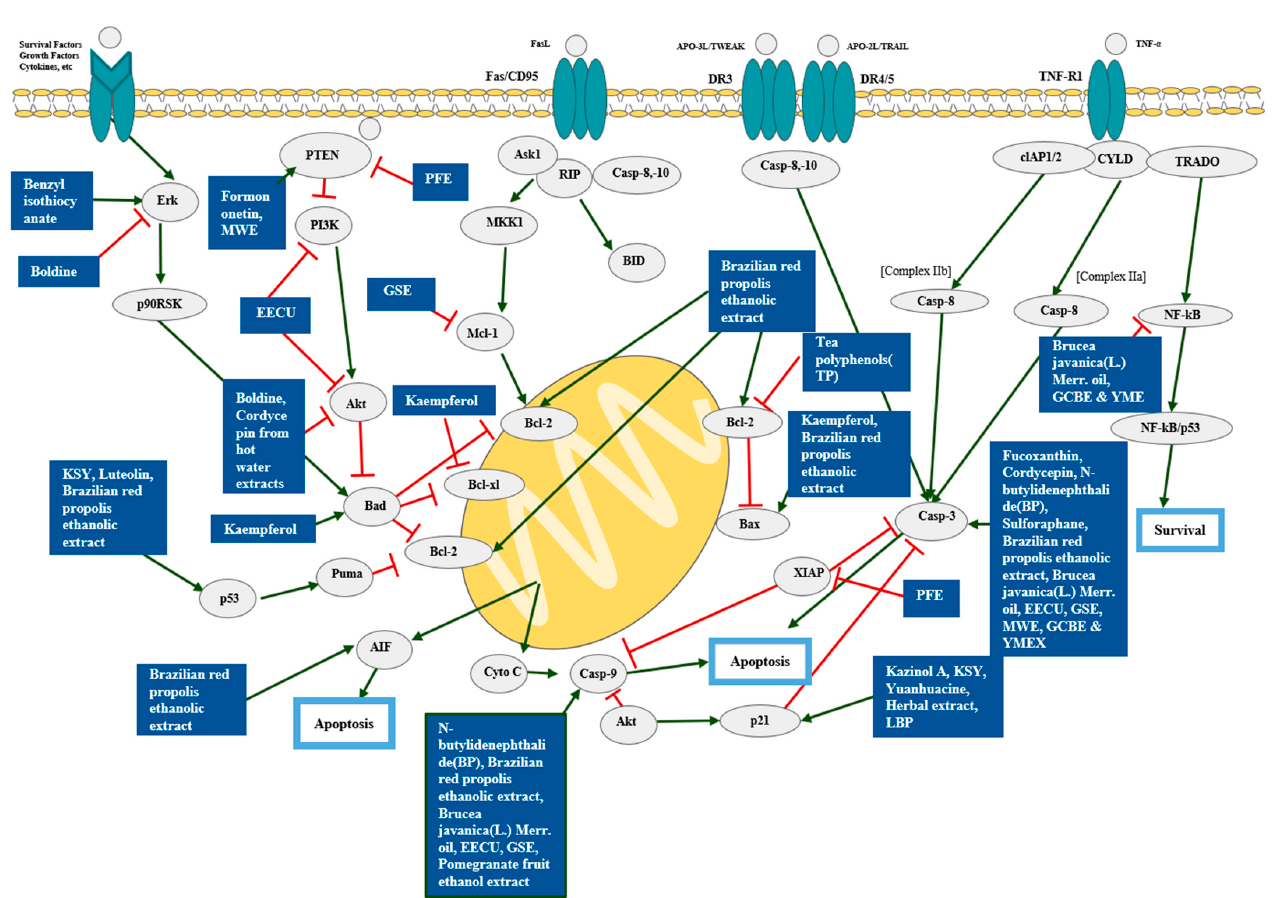
Figure 2. Schematic diagram of apoptosis. After factors such as FasL, APO-3L, APO-2L, and TNF- α attaching to the receptors located in cell membrane, apoptosis begins. Bad and Mcl-1 protein regulate Bcl-2 family, which control release of proteins from the space between the mitochondrial inner and outer membrane. Then, Bcl-2 family regulates proteins such as Cyto C, and Cyto C activates caspase-9. Finally, Caspase-9 induces apoptosis [68,69]. On the other hand, apoptosis also occurs by caspase-3, which is activated by caspase-8 and caspase-10. Various natural products induced apoptosis by regulating key molecules of apoptosis. Abbreviation: AIF, Apoptosis-inducing factor; Akt, Protein kinase B, Ask1, Apoptosis signal-regulating kinase 1; APO-3L/TWEAK, APO3 ligand or TNF-related weak inducer of apoptosis; APO-2L/TRAIL, Apo2 ligand or tumor necrosis factor-related apoptosis-inducing ligand; Bad, BCL2 associated agonist of cell death; Bax, Bcl-2 Associated X-protein; Bcl-2, B-cell lymphoma 2; BID, BH3 Interacting Domain Death Agonist; Casp-8, Caspase-8; Casp-10, Caspase-10; Casp-9, Caspase-9; Casp-3, Caspase-3; CD95, cluster of differentiation 95; clAP1/2, cellular inhibitor of apoptosis 1 and 2; CYLD, Cylindromatosis ; Cyto C, Cytochrome c; DR3,